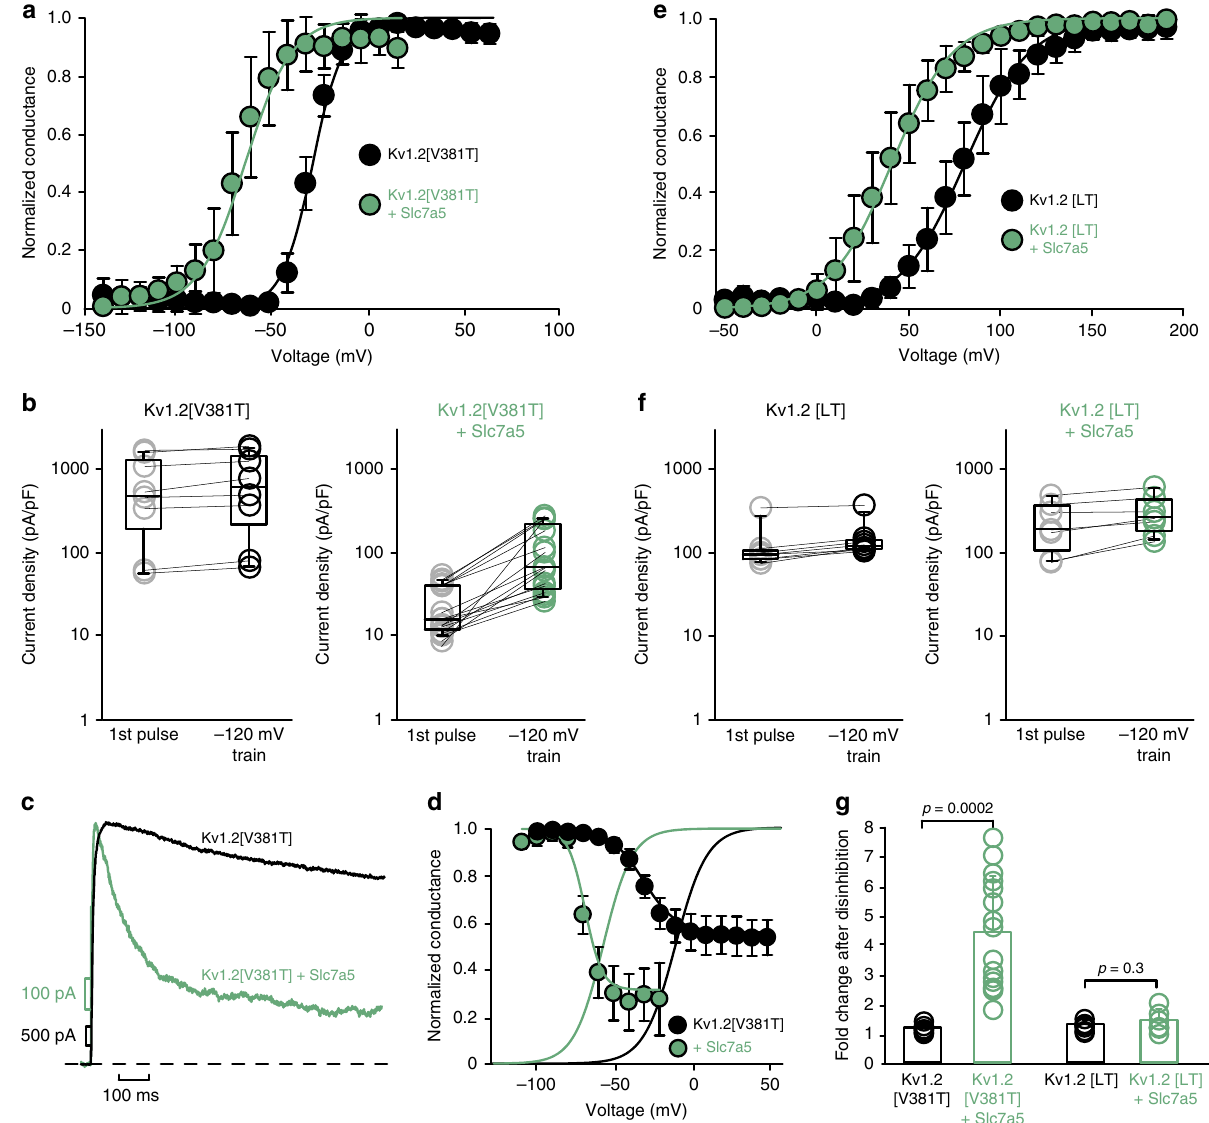
Fig. 5 Slc7a5 in fl uences inactivation of Kv1.2. a Kv1.2[V381T] channels were expressed alone or with Slc7a5 (1:1 transfection ratio). Conductance-voltage relationships were generated with the same protocol as Fig. 4, after disinhibition by a 30 s hyperpolarization to − 120 mV (Kv1.2[V381T] V 1/2 = − 16 ± 4 mV, k = 8.5 ± 0.7 mV, n = 6; + Slc7a5 V 1/2 = − 55 ± 11 mV, k = 13.1 ± 3.2 mV, n = 8). b Current density at + 60 mV was measured at the beginning and of a pulse train with − 120 mV holding potential (identical to Fig. 3; Kv1.2[V381T] n = 8; + Slc7a5 n = 16). c Exemplar traces of Kv1.2[V381T] ± Slc7a5 (green) currents elicited by a 1 s depolarization to + 60 mV (after current disinhibition by holding at − 120 mV). d Steady-state inactivation was measured by pulsing to test voltages for 6 s and allowing channels to recover for 7 s at − 100 mV. Curves were fi t with a Boltzmann function (Kv1.2[V381T] V 1/2 = − 31 ± 3 mV, k = 11.1 ± 2.1 mV, n = 5; Kv1.2[V381T] + Slc7a5 V 1/2 = − 69 ± 6 mV, k = 6.7 ± 1.8 mV, n = 5). e , f Identical experiments as in a , b were performed with Kv1.2[LT] channels (Kv1.2[LT] V 1/2 = + 80 ± 10 mV, k = 18 ± 2 mV, n = 7; + Slc7a5 V 1/2 = + 40 ± 11 mV, k = 17 ± 2 mV, n = 7). g Current disinhibition (fold change in current after a − 120 mV pulse train) for Kv1.2[V381T] ( n = 8, 16) or Kv1.2[LT] ( n = 7, 7). Bars represent mean ± s.d., Student ’ s t -test was used to compare Slc7a5-mediated disinhibition vs. control with each channel type